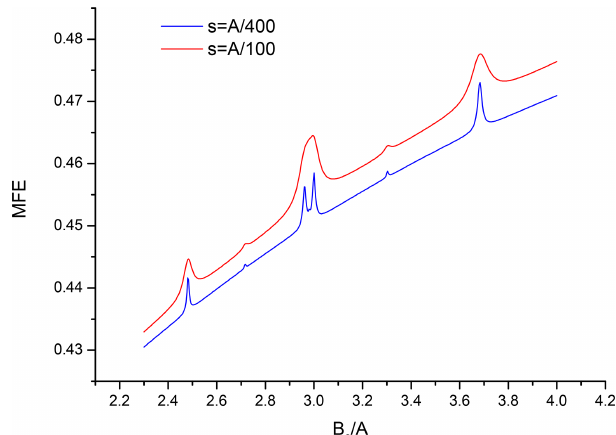
Figure 4. Region in the vicinity of B 0 = 3 A for a pair with six equivalent spin- 1 nuclei with HFC constant A in one partner and 2 two non-equivalent spin- 1 nuclei with HFC constant A/ 10 and 2 A/ 40 in the second partner, recombination parameter s = A/ 100, s = A/ 400.